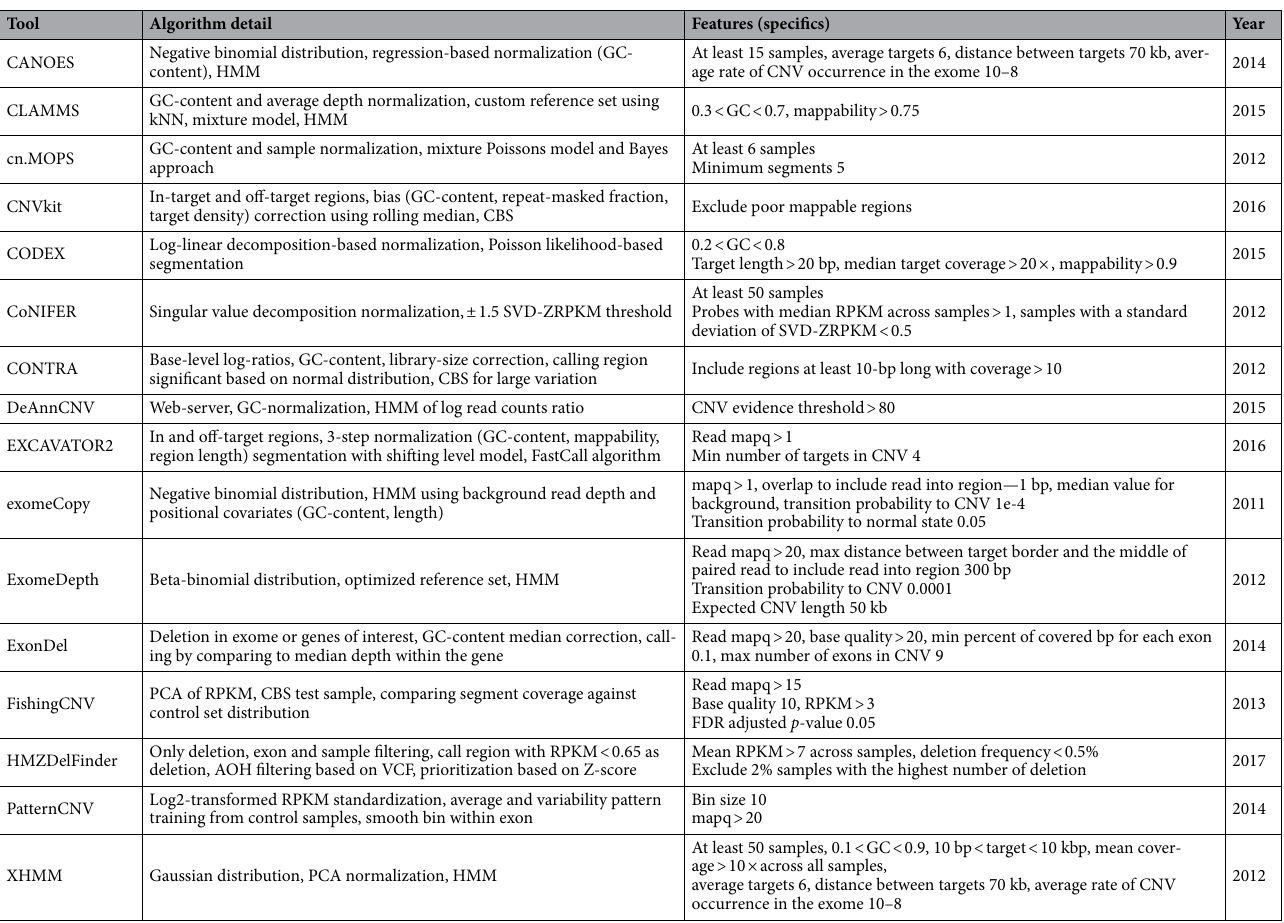
Table 1. CNV calling tools included in the